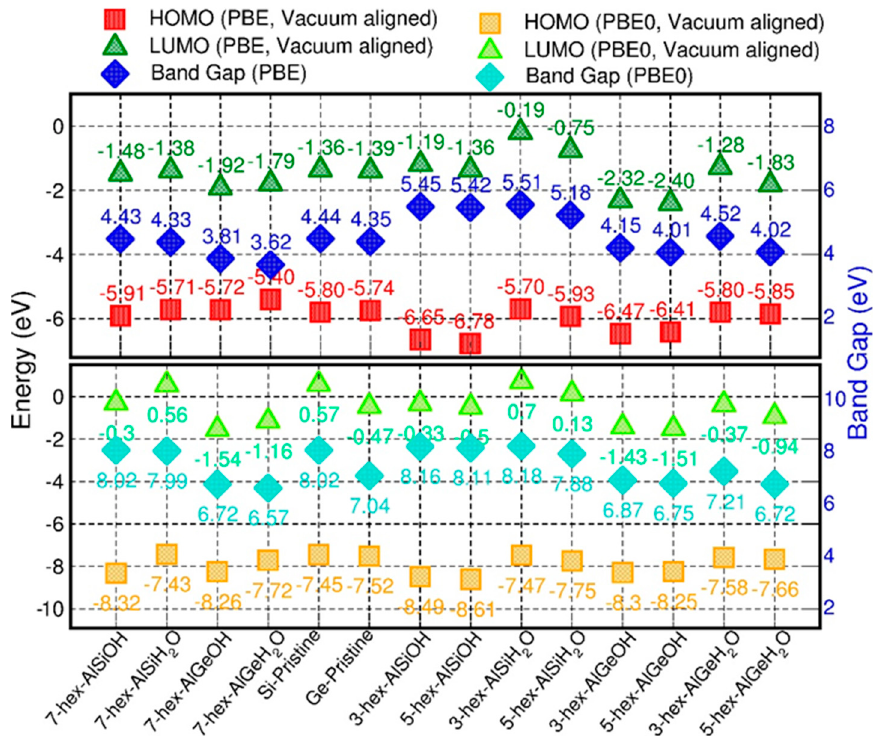
Figure 6. PBE and PBE0-TC-LRC (shorthand notation: PBE0) vacuum-aligned VB and CB edges, and resulting BGs, for the OH- and H 2 O-terminated finite models of the AlSi and AlGe NTs, together with the results for their fully periodic counterparts.